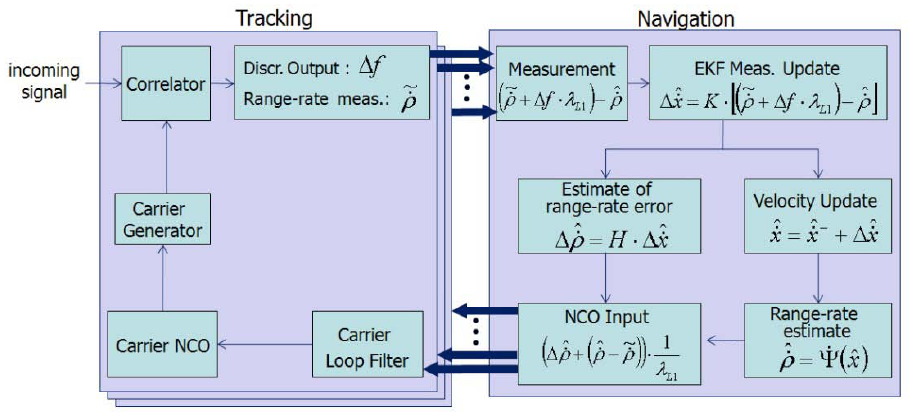
Figure 6. Construction of the